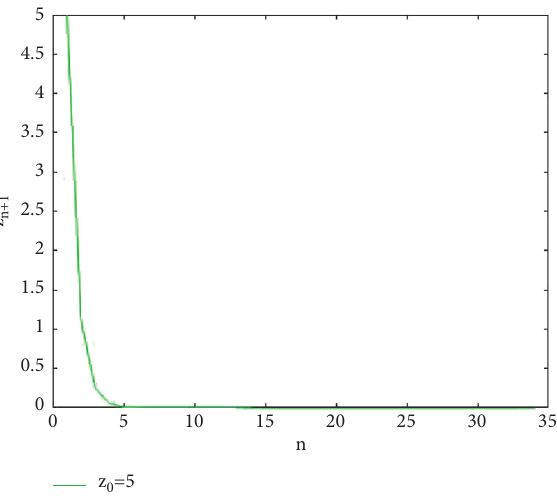
Figure 3: Case III: for the initial value z